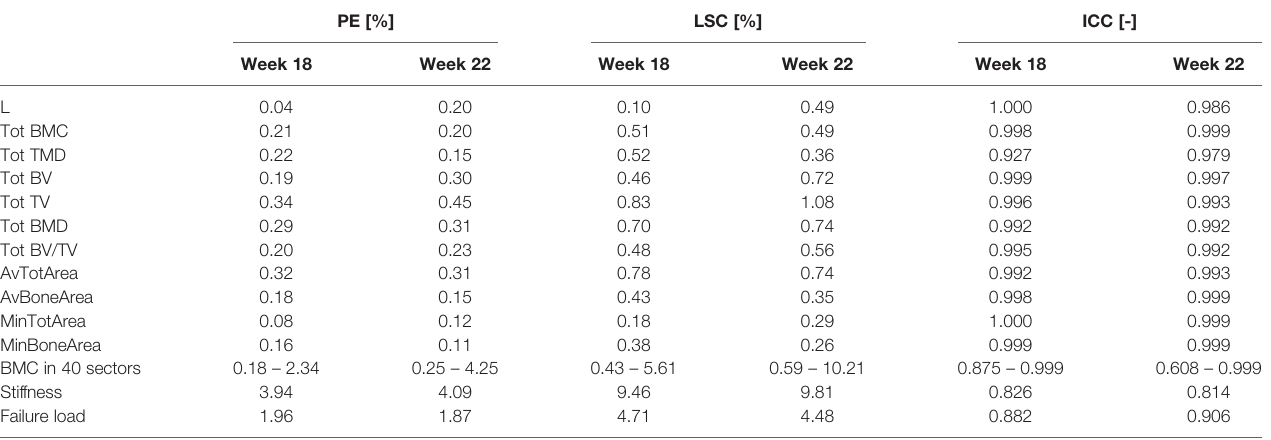
TABLE 3 | Inter-operator reproducibility of densitometric and mechanical parameters. PE